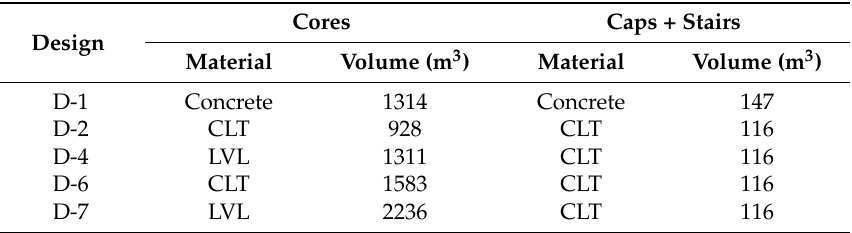
Table 5. Material quantities considered for